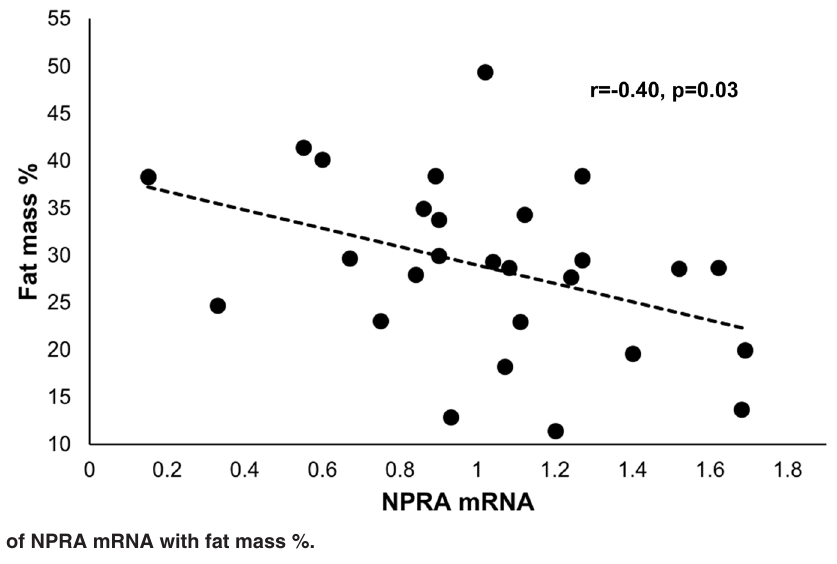
Figure 1. Association of NPRA mRNA with fat mass